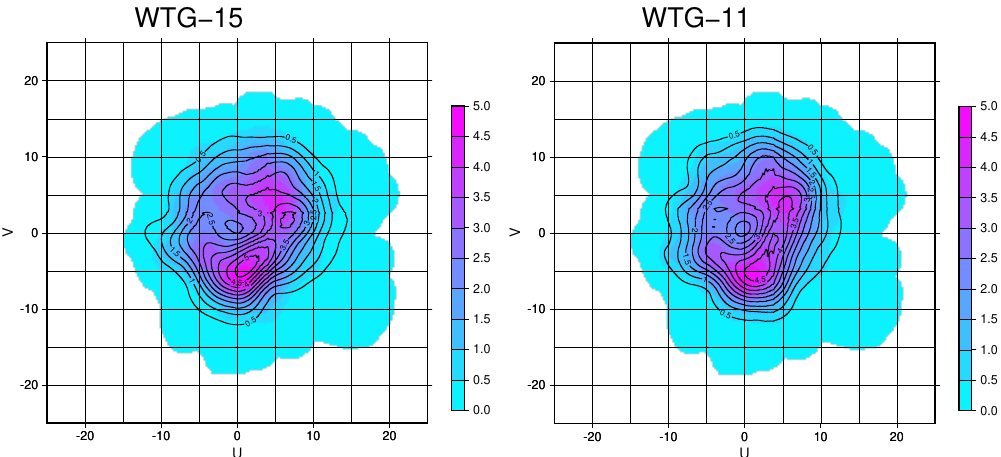
Figure 3. Two-dimensional probability density function ( × 1000) corresponding to wind from the nearest ERA5 grid point (color shades) and the WTG-15 anemometer and wind-vane (left, contours). The right panel represents the two-dimensional probability density function ( × 1000) corresponding to ERA5 data (colored shades) and the WTG-11 anemometer